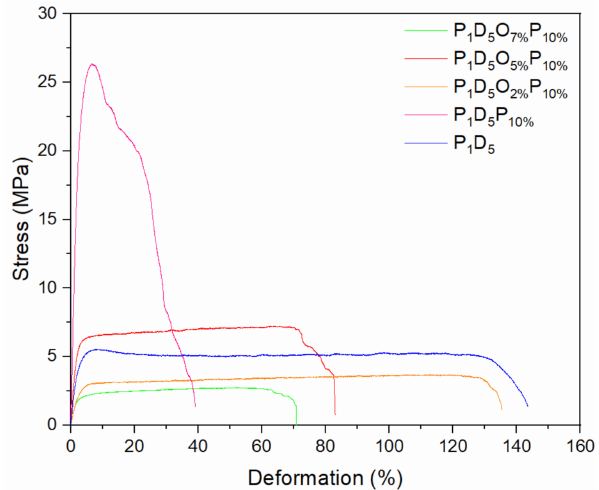
Figure 4. Strain–stress curves of polymer membranes prepared with different OVAPOSS additions. Figure 5 is the thermogravimetric (TG) curve of each membrane in an argon atmo- sphere. It was found that the membrane was relatively stable before 430 ◦ C. After 430 ◦ C, with the continuous increase of the temperature, the membrane would be thermally de- composed. At 550 ◦ C, the membrane was basically completely decomposed. Figure 6 is a comparison diagram of the thermal shrinkage of each group of membranes. Each group of membranes could maintain the original shape at 120 ◦ C. When the temperature was raised to 130 ◦ C, the polypropylene (PP) membrane shrank to 60% of its original size, and it could no longer play the role as a membrane, while there was no significant change in the membranes of the other groups. When the temperature rose to 140 ◦ C, the PP membrane further shrank, and the color changed from white to transparent. The P 1 D 5 P 10% membrane also changed from translucent to transparent. However, there was basically no obvious change in the other groups. When the temperature rose to 150 ◦ C, the P 1 D 5 membrane and the P 1 D 5 P 10% membrane ruptured, while the sizes of the P 1 D 5 O 5% P 10% membrane and the P 1 D 5 O 7% P 10% membrane basically did not change, and the color of them turned slightly yellow. This was because the OVAPOSS filler in the membrane generated SiO 2 in the oxygen environment, and a protective layer was formed on the surface of the polymer to prevent the shrinkage of the polymer membrane, thereby ensuring the safety of the battery at high temperatures. The normal operating temperature of lithium-ion batteries is below 80 ◦ C, indicating that the PVDF–HFP-based gel electrolyte can be used safely.